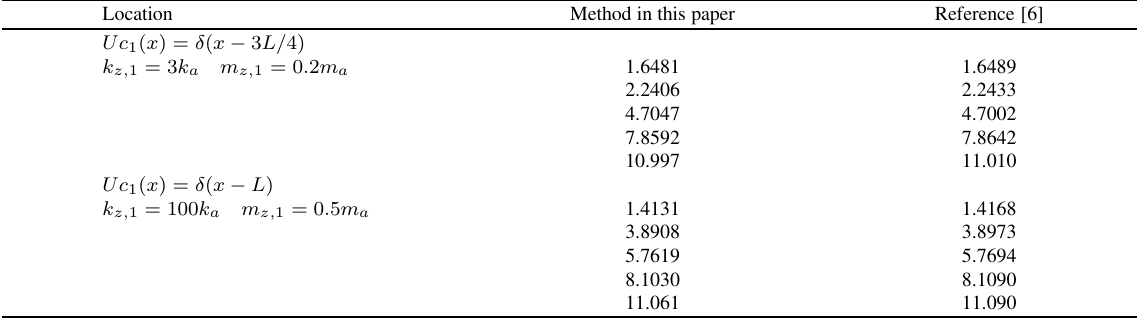
The natural frequency coefficients β i for a cantilever beam carrying a spring-mass system Location